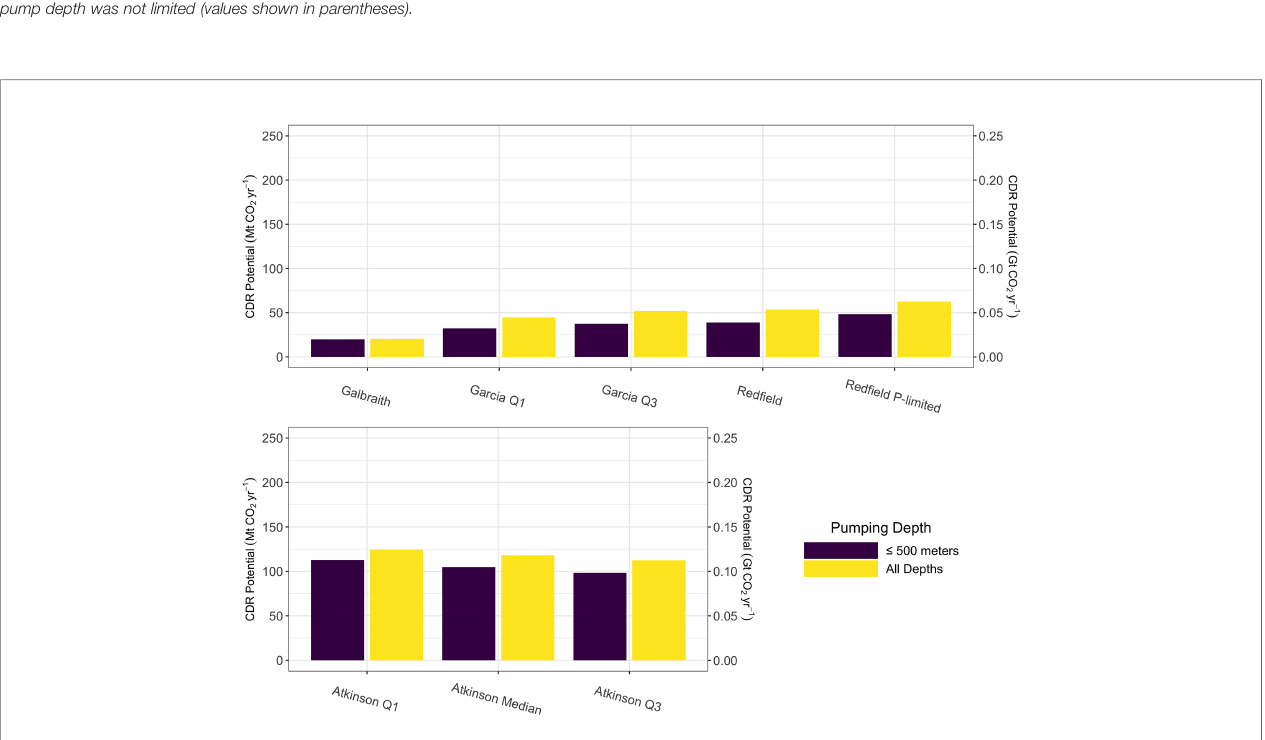
FIGURE 4 | Projected global-scale carbon dioxide removal potential after areally integrating positive potential carbon dioxide removal values from Figure 2 (purple) and Figures S1 (yellow) for microalgae stoichiometries (top row) and macroalgae stoichiometries (bottom row).